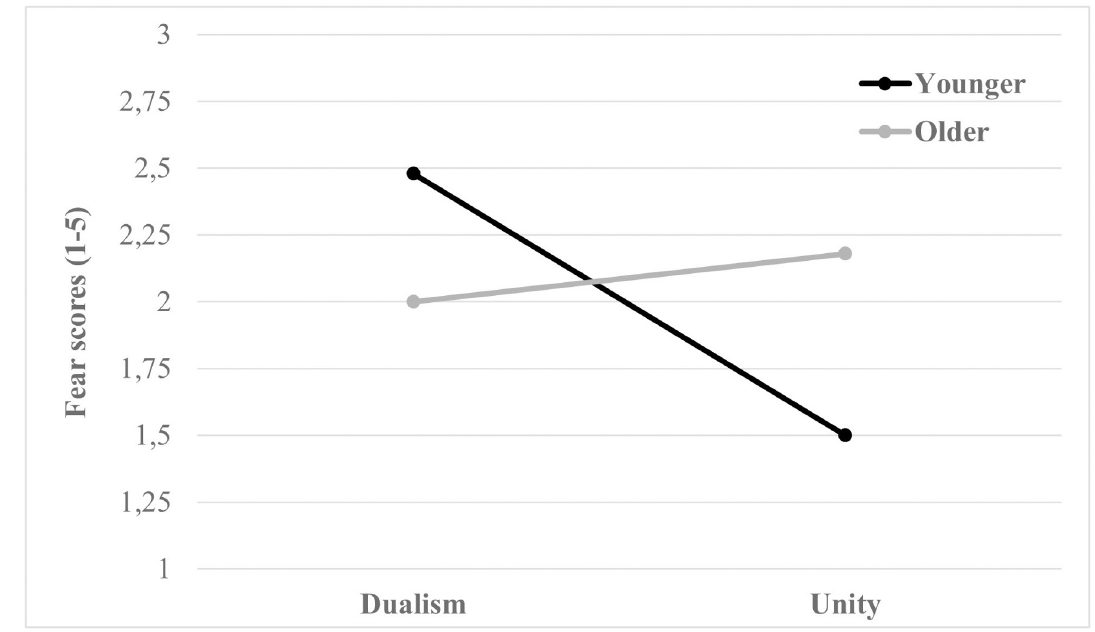
Fig 4. Effect on self-report fear of the interaction between framing and